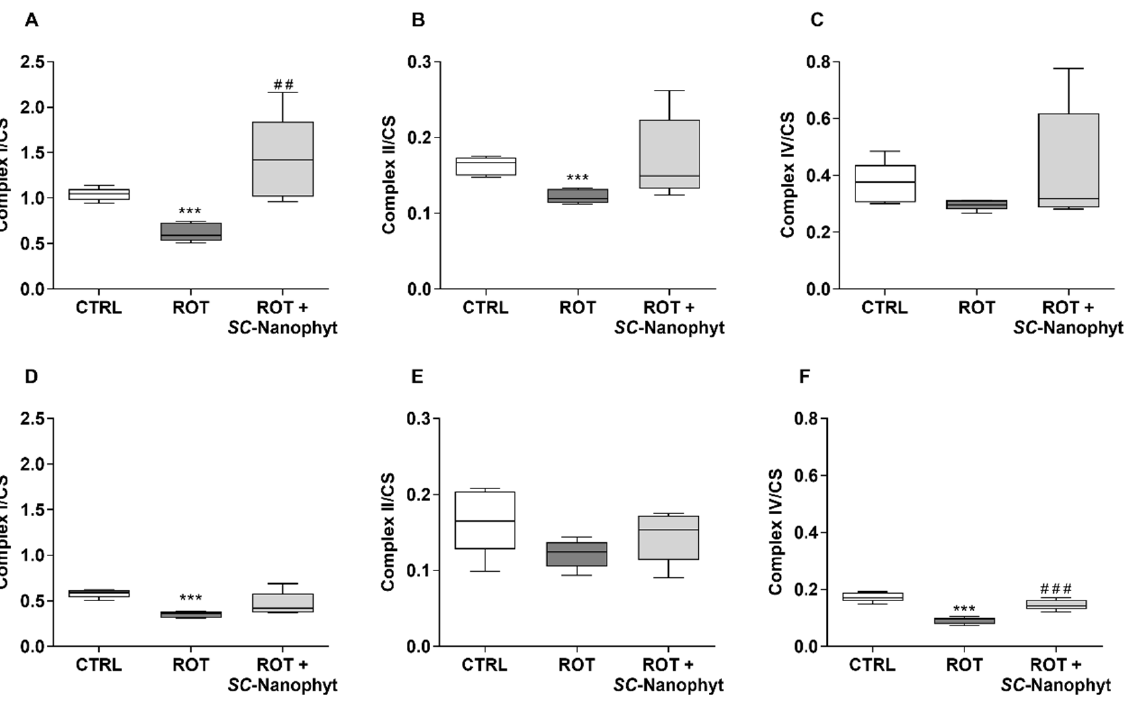
Figure 5. Mitochondrial complexes I ( A , D ), II ( B , E ), and IV ( C , F ) activity in the mitochondria-rich fraction from BG-Cereb ( A – C ) and C-Cortex ( D – F ) brain portions of CTRL, ROT, and ROT + SC - Nanophyt groups normalized by CS activity. Error bars represent SEM for n = 5 independent experiments using five animals in each one. *** Significantly different from CTRL group, with p < 0.001. ## , ### Significantly different from ROT group, with p < 0.01 and p < 0.001, respectively.